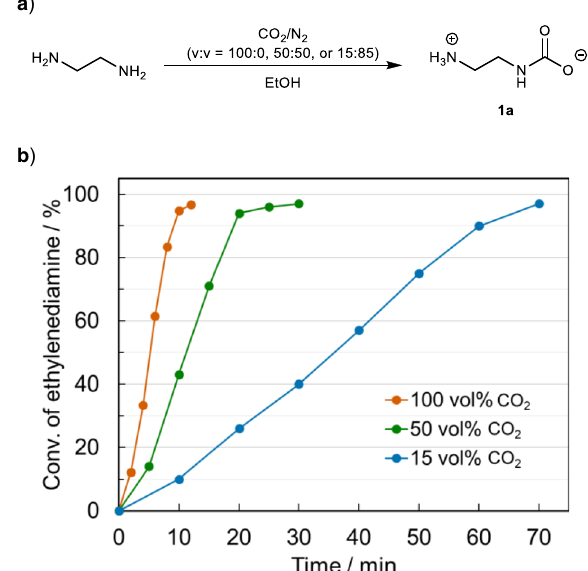
Fig. 1 Ef fi ciency of formation of 1a by bubbling various concentrations of CO 2 . a Synthesis of 1a from ethylenediamine by bubbling various concentrations of CO 2 . Reaction conditions: ethylenediamine (1.2 g, 20 mmol), EtOH (50 mL), gas fl ow rate (50 mL/min). b Plot of the conversion rate of ethylenediamine as a function of bubbling time of pure CO 2 gas and CO 2 /N 2 mixed gases: red curve: pure CO 2 , green curve: CO 2 / N 2 = 50:50 (v/v), and blue curve: CO 2 /N 2 : 15:85 (v/v). Conversions of ethylenediamine were calculated from 1 H NMR spectra using mesitylene as an internal